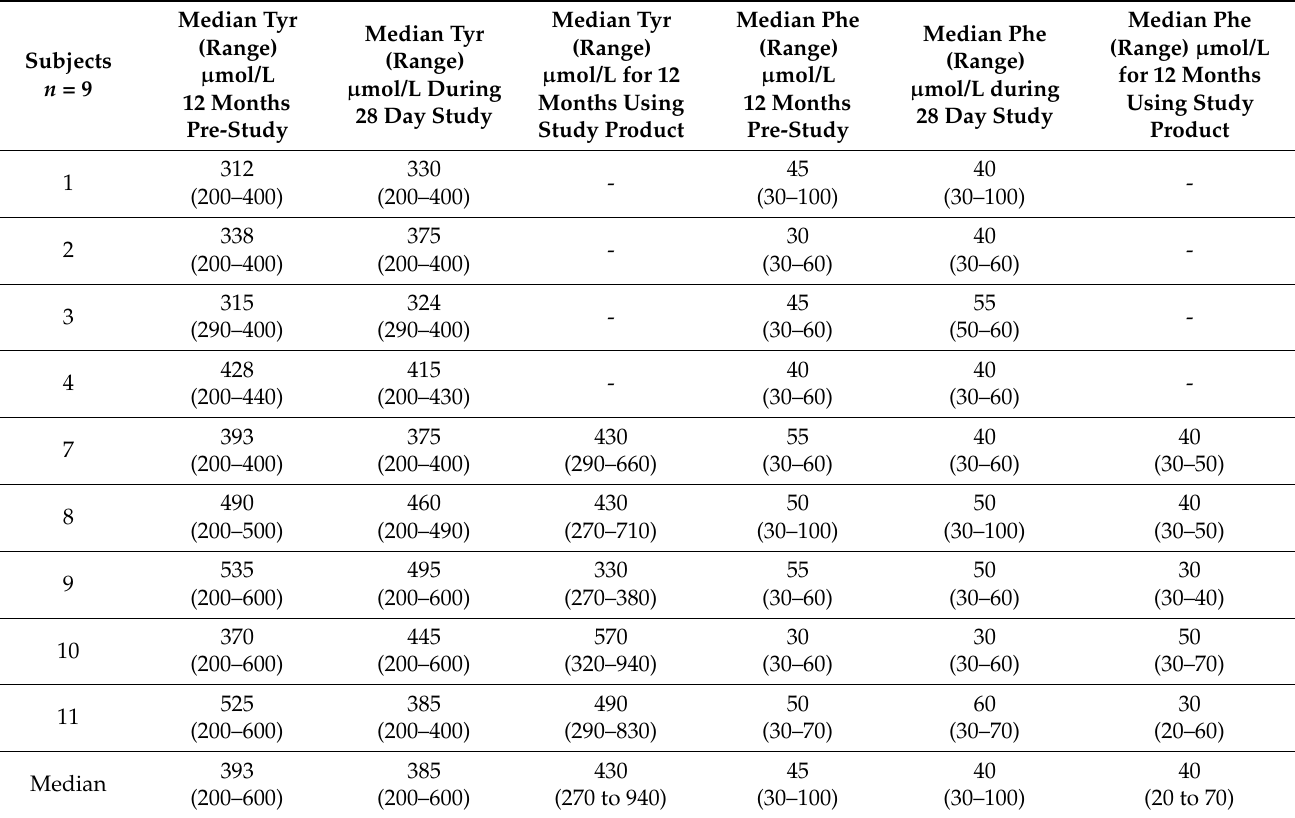
Table 3. Median tyrosine and phenylalanine blood concentrations (range) for study part 1, 28 days and part 2, follow-up over 12 months when taking the study protein substitute ± amino acid